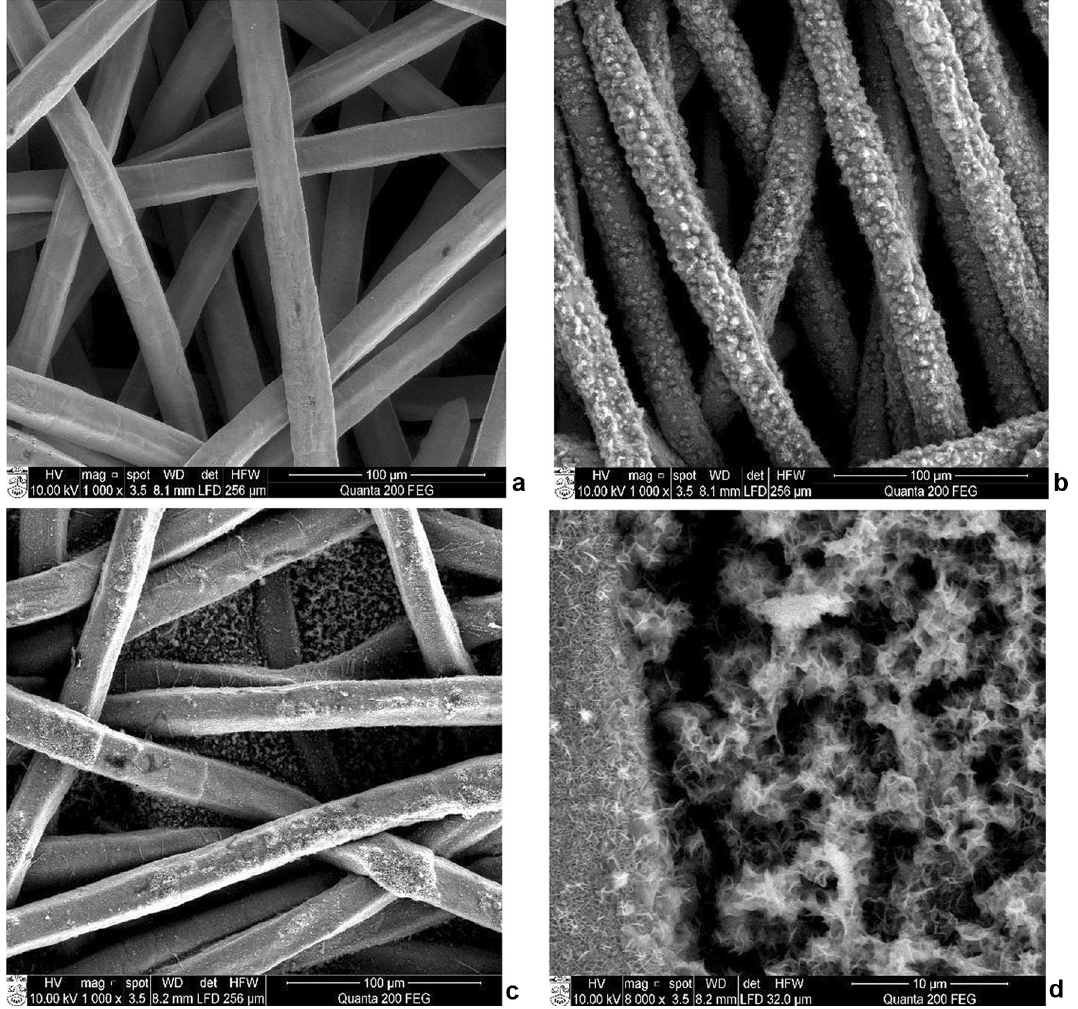
Fig. 2 Representative SEM images of clean Bekipor ST20AL3 stainless steel mesh ( a ) and as-deposited cobalt hydroxide films at different deposition times (s): b –120, c and d –300. Magnifications: a , b , c 9 1000, d 9